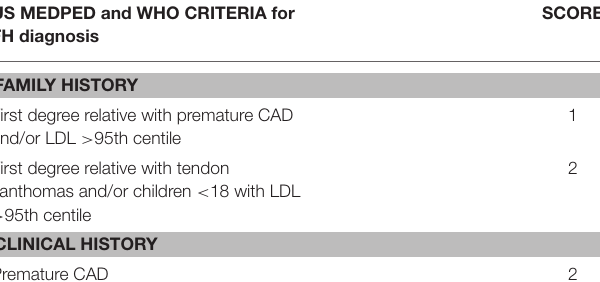
TABLE 2 | MEDPED and WHO criteria for FH diagnosis. US MEDPED and WHO CRITERIA for FH diagnosis